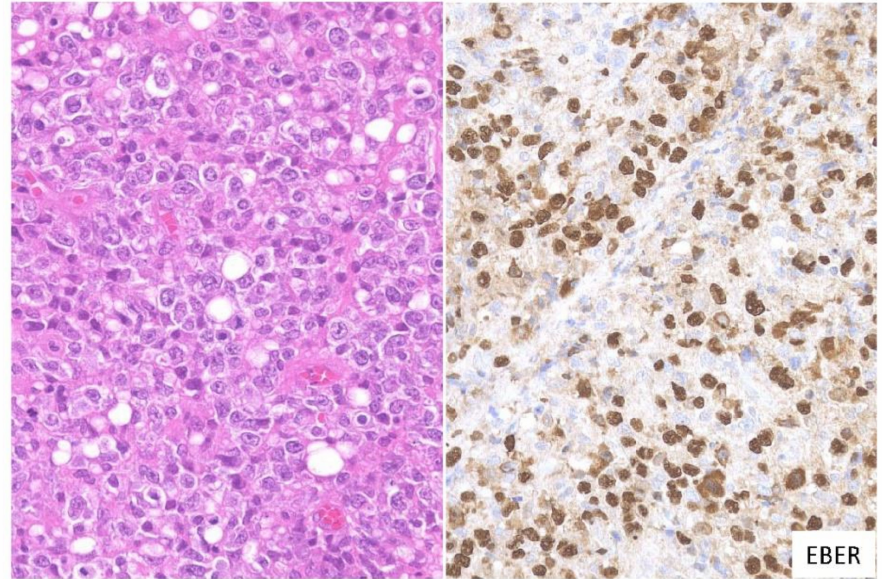
Figure 3. Pathologic findings for large cell-rich EBVMCU. An EBVMCU in the maxilla. The lesion shows monomorphic and dense proliferation of atypical large lymphoid cells resembling diffuse large B-cell lymphoma (DLBCL). In situ hybridization shows atypical cells positive for EBER (HE staining; magnification, ×